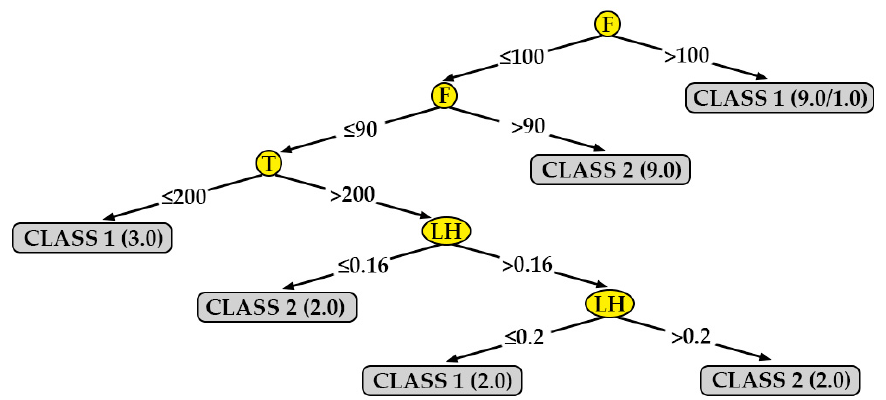
Figure 7. Decision tree for surface roughness measured in the direction parallel to the extrusion path on printed specimens in the XY orientation (R a,0,XY ).